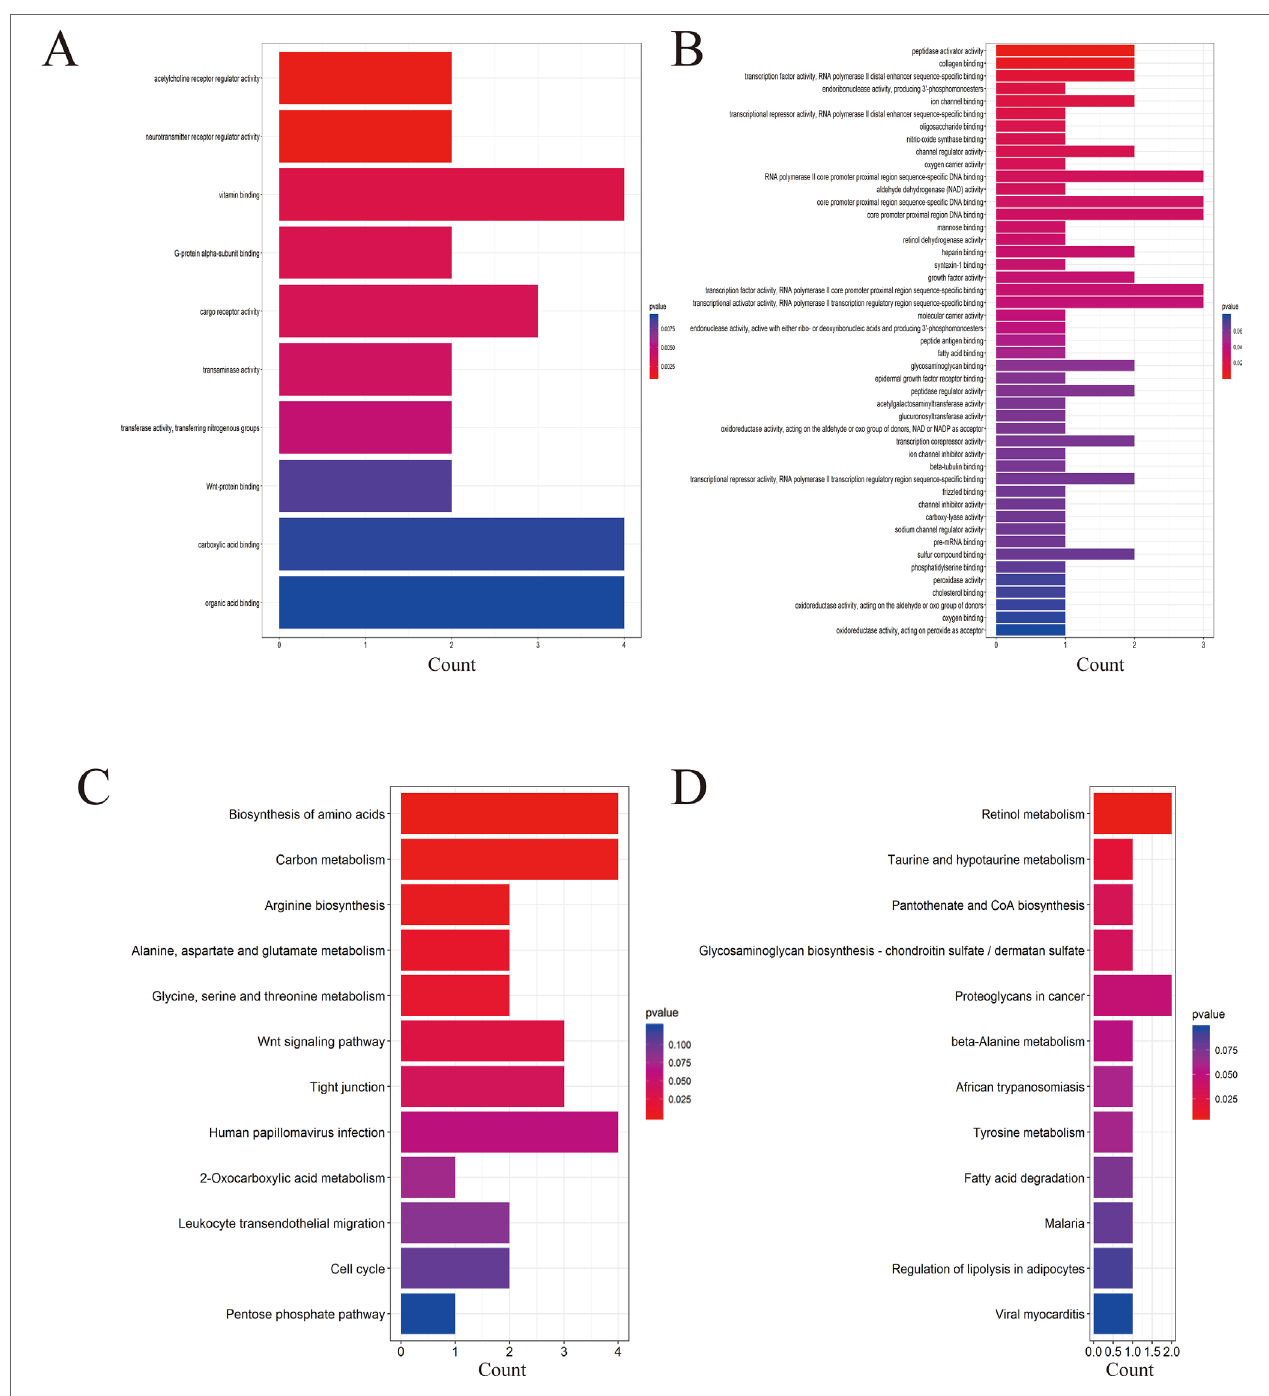
FIgUrE 2 | Gene Ontology (GO) and Kyoto Encyclopedia of Genes and Genomes (KEGG) analysis of the up- and downregulated DEGs. (A) GO analysis of upregulated genes associated with epithelial ovarian cancer (EOC). (B) GO analysis of downregulated genes associated with EOC. (C) KEGG analysis of upregulated genes associated with EOC. (D) KEGG analysis of downregulated genes associated with EOC.